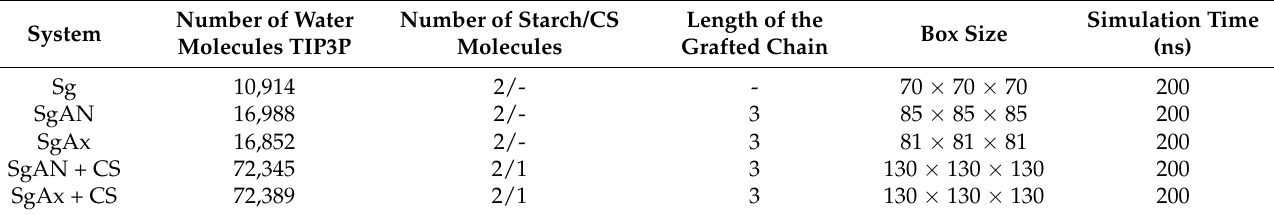
Table 3. Molecular dynamic composition of the simulated